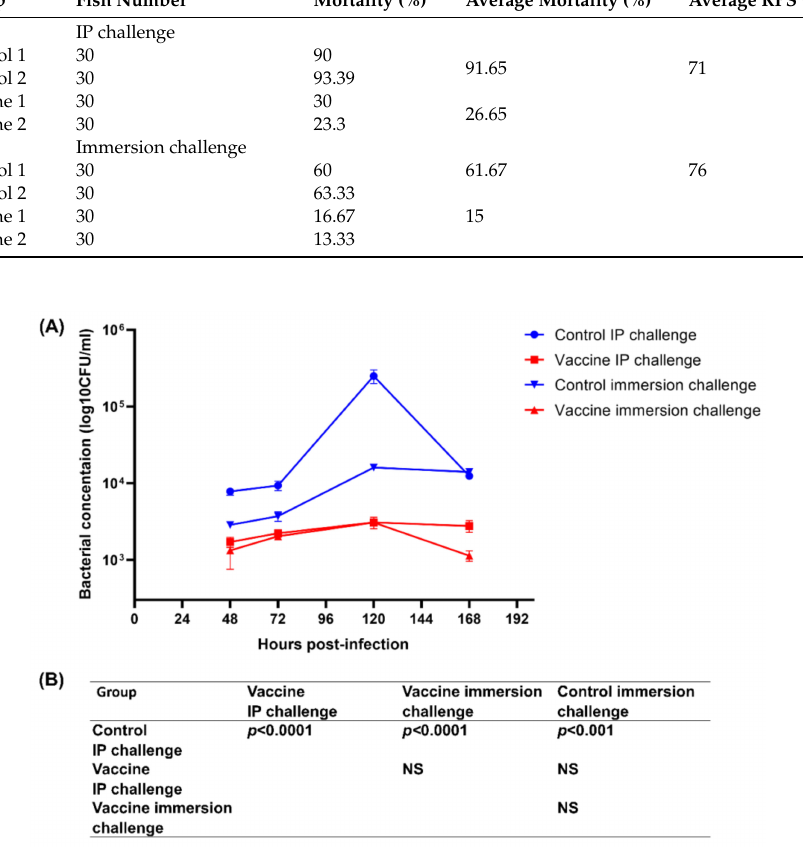
Figure 4. Comparison of blood bacterial concentrations between control and vaccinated fish after 24 h, 48 h, 72 h, 120 h, and 168 h post-infection (n = 3) ( A ). The di ff erences among groups were tested using a one-way ANOVA with Tukey’s post hoc test ( B ). NS = Not